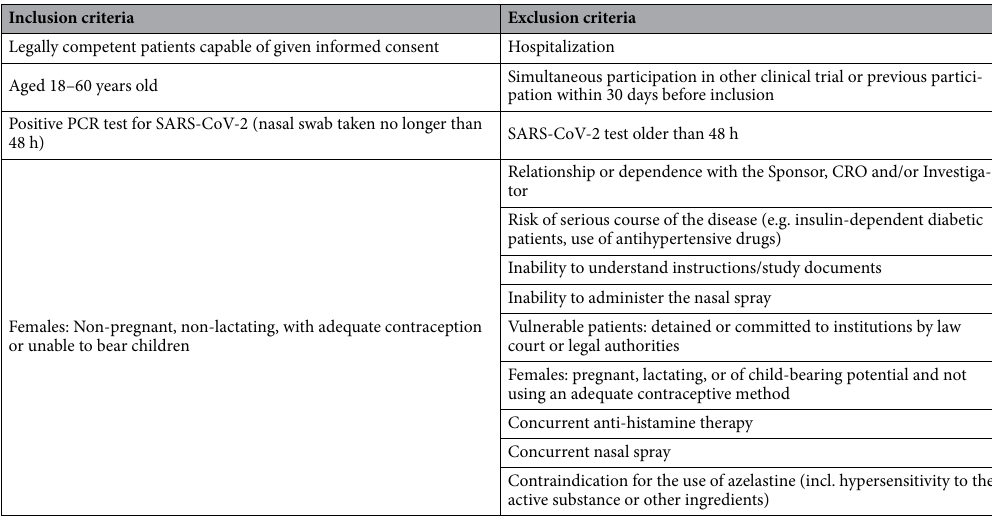
Table 1. Inclusion and exclusion criteria for study